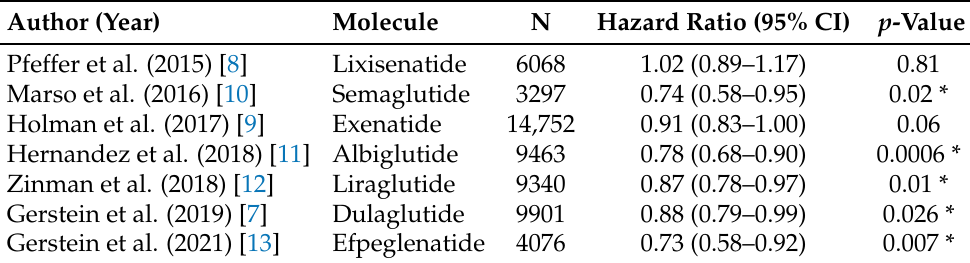
Table 1. The effects of GLP-1 RAs on relative MACE reduction compared to placebo: The results from